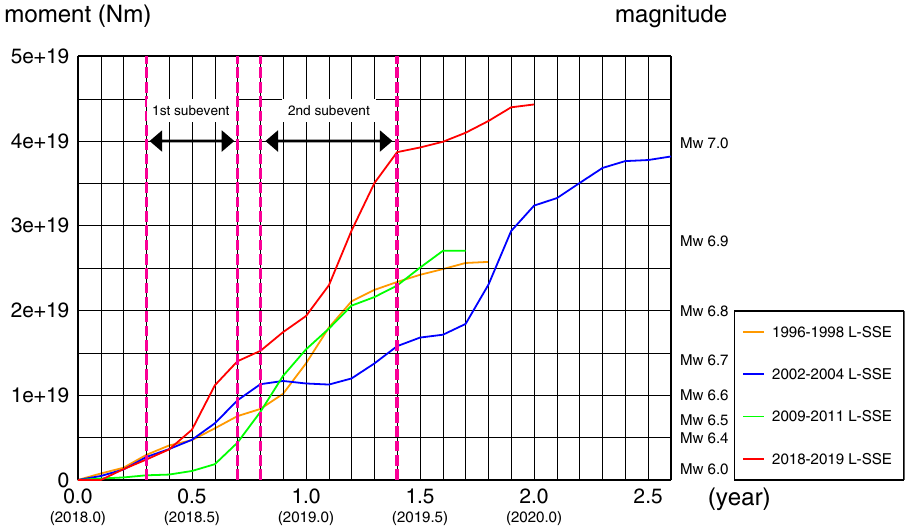
Figure 5. Time variation of the released seismic moment and equivalent moment magnitude for the Bungo Channel L-SSEs. The orange, blue, green, and red lines represent the 1996–1998 L-SSE, 2002–2004 L-SSE, 2009–2011 L-SSE, and 2018–2019 L-SSE, respectively. The pink dashed lines represent the durations of the two subevents of the 2018–2019